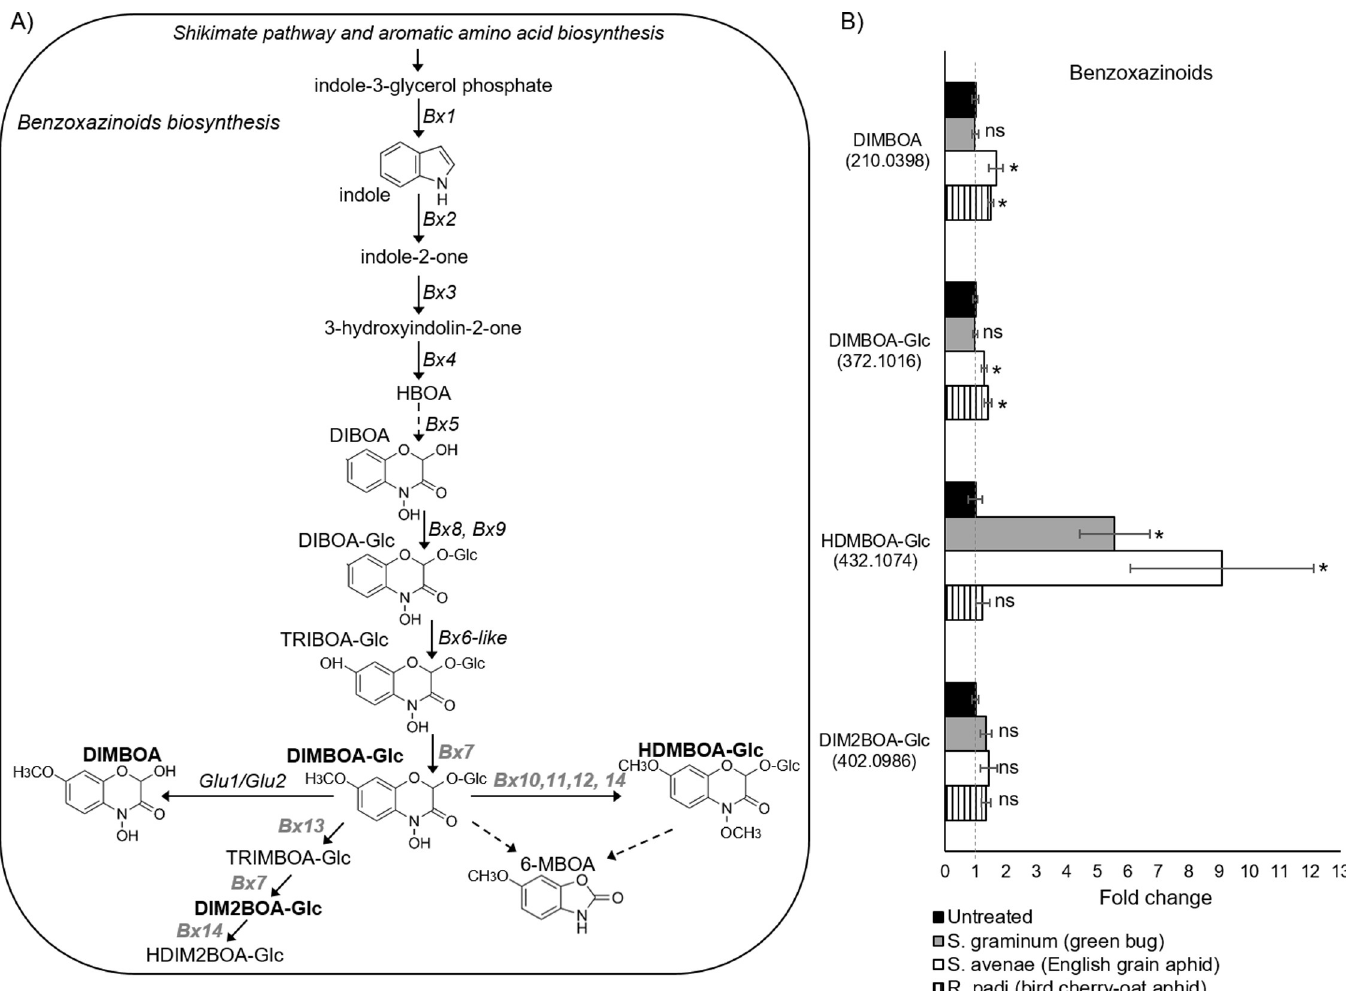
Fig 3. Effects of aphid feeding on benzoxazinoid levels after 96 hr of infestation. A) Schematic representation of benzoxazinoid biosynthesis showing the main enzymatic reactions and intermediates. In grey are the names of genes and metabolites that are detected in maize but are still unknown in wheat. In bold are the four benzoxazinoids that are presented in this research. B) DIMBOA, DIMBOA-Glc, HDMBOA-Glc and DIM2BOA-Glc levels modified under the attack of three cereal aphid species relative to the untreated control. An asterisk indicates the values that were determined by the Student’s t-test to be significantly different ( P value < 0.05) from the untreated control (n = 4–5). ns: not